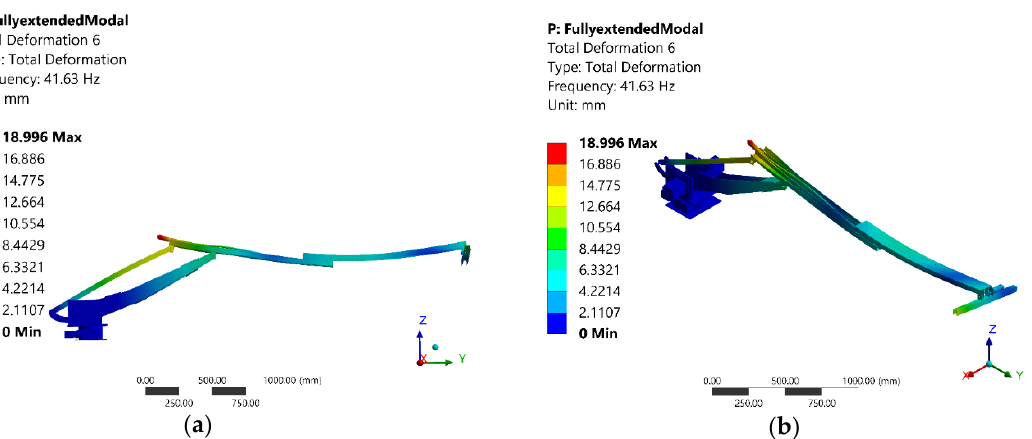
Figure 10. The 5th mode shape of vibration for the Fully-extended configuration, arm is fixed at the base ( a ) side view & ( b ) isometric view.